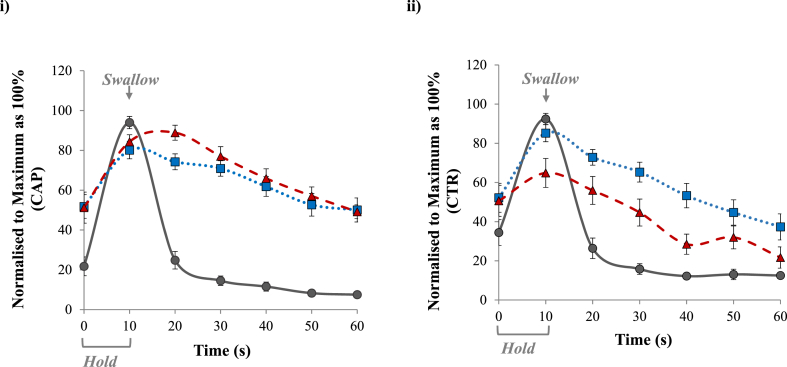
Impact of capsaicin with a combination of analytical and sensory data. Data were normalised to the individual's maximum values as 100%, and the results showed in the figure were the average of 15 subjects. i) capsaicin solution (CAP) and ii) control solution (CAP). Normalised aroma release (solid grey line with the dots), aroma perception (blue dotted line with squares) and spiciness perception (red dashed line with the triangle) during 60 s observation period. (For interpretation of the references to colour in this figure legend, the reader is referred to the Web version of this article.)